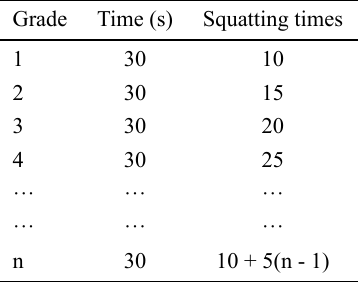
Fig. 4. Action standard of squatting down. Table 2. Squatting times of each grade.